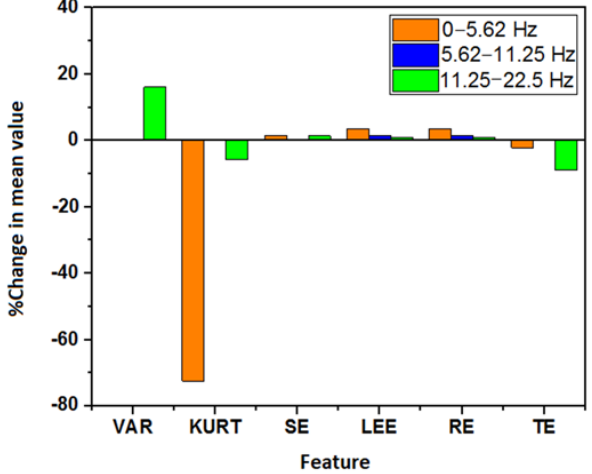
Figure 9. Percentage change in the mean values of the significant features obtained in the different